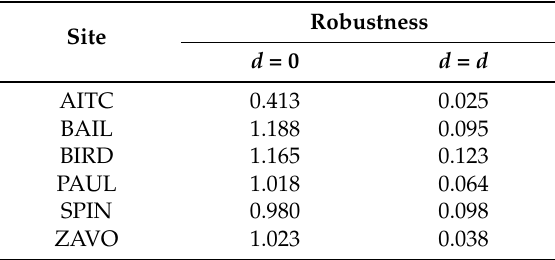
Robustness of the master ruleset when adapted from the reference image to the candidate